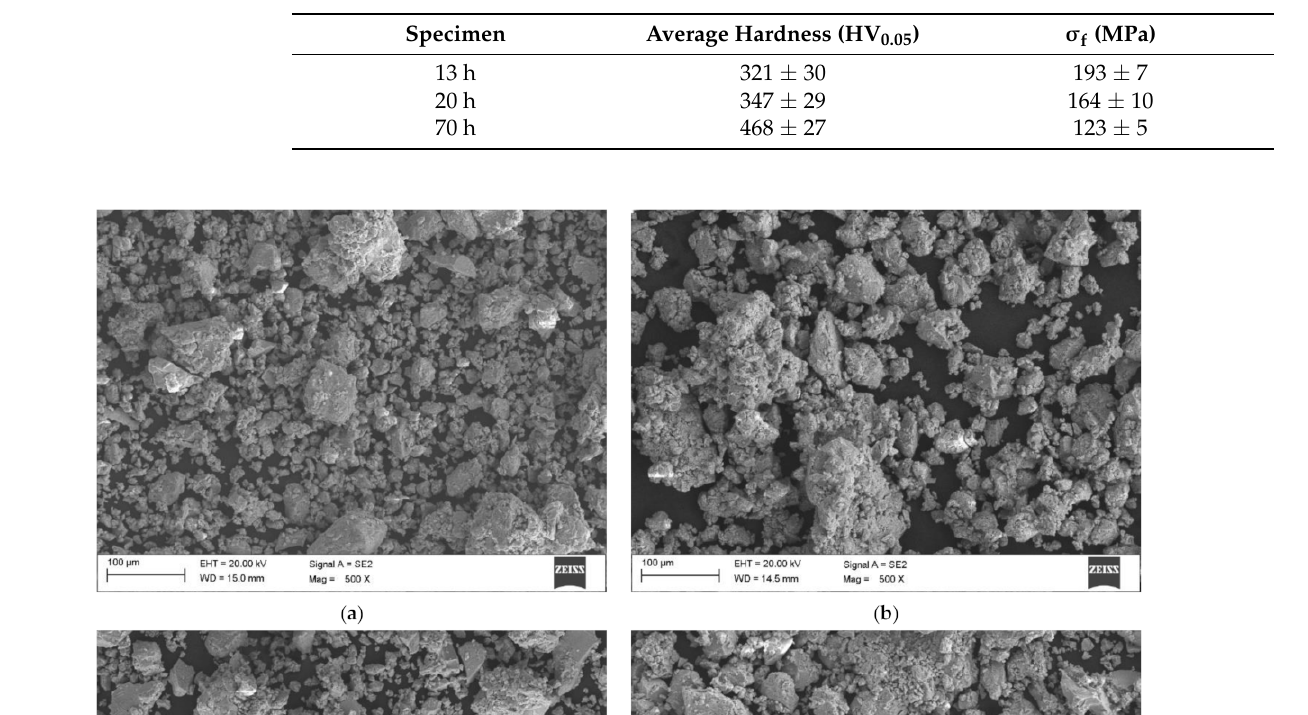
Table 5. Microhardness and bending strength values σ f for Mg-Zn-Ca-Pr alloy specimens sintered from powders milled for a varied amount of time. All results are presented as the mean ± standard deviation (SD).